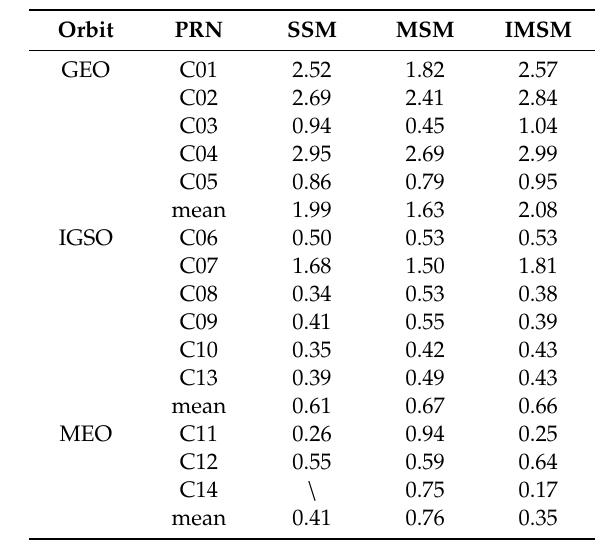
Figure 6. Double-di ff erenced (DD) clock o ff sets derived from the single-satellite method (SSM), the multi-satellite method (MSM), and the improved multi-satellite method (IMSM) for CLK16 on day of year 256, 2019. Table 2. Standard deviation (STD) of double-di ff erenced clock o ff set obtained by the single-satellite method (SSM), the multi-satellite method (MSM), and the improved multi-satellite method (IMSM) for CLK16 on day of year 256, 2019 (units: